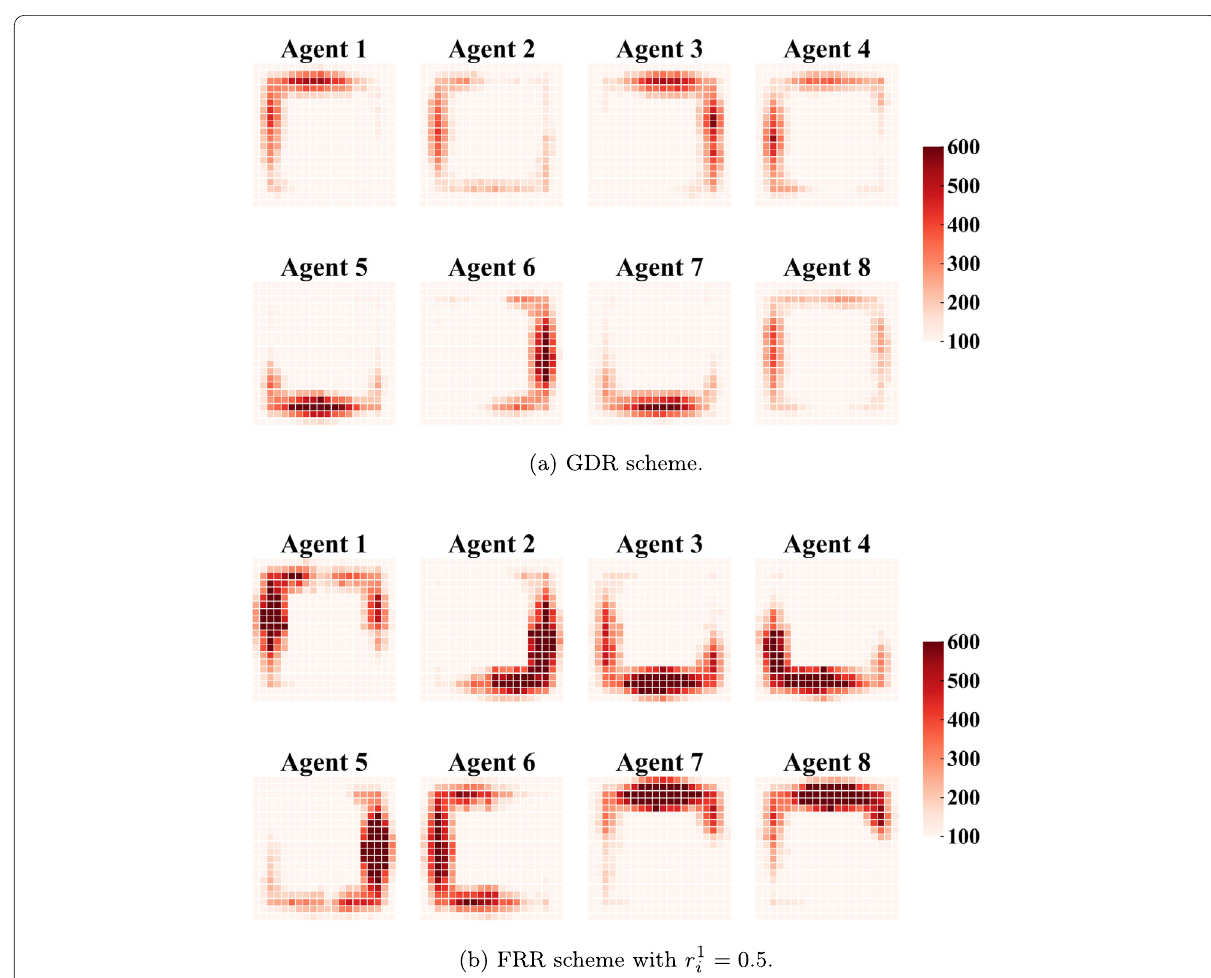
Figure 7 Number of materials by cells placed by carrier agents